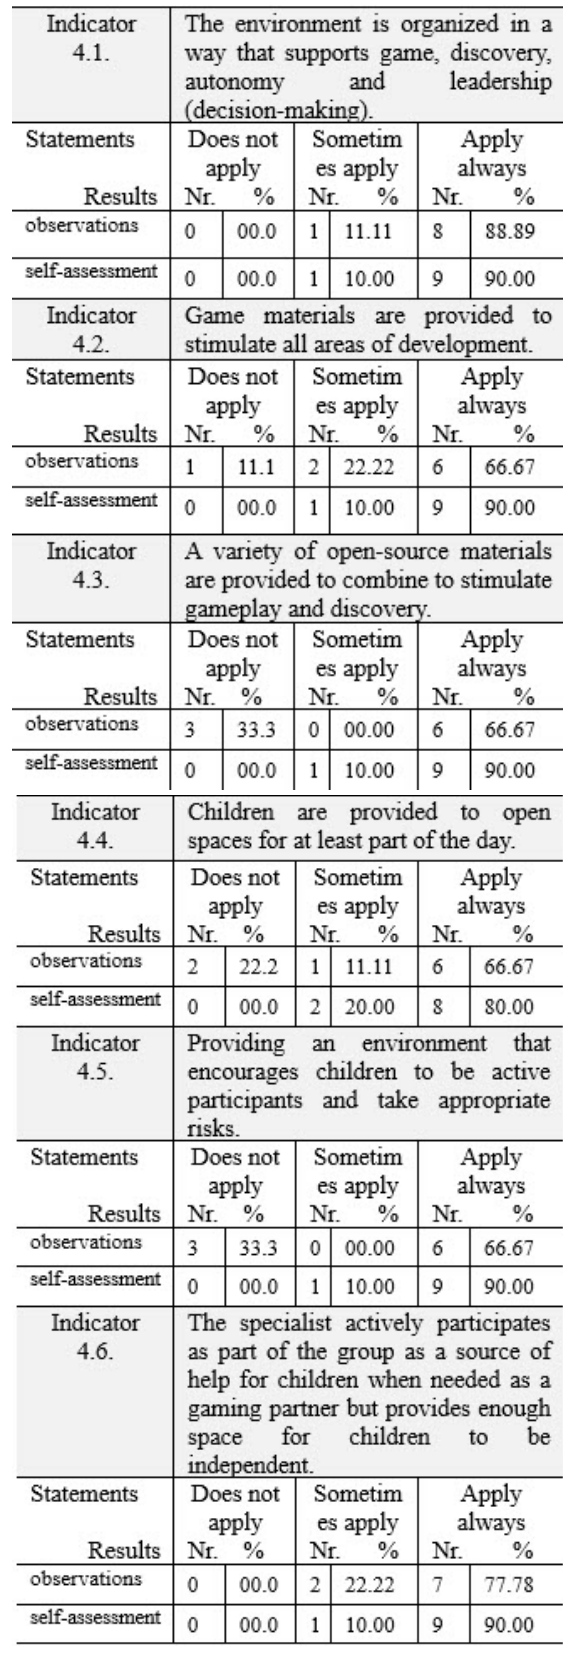
Table 29. Principle 4: The environment stimulates children’s play, discovery, indepen - dence and